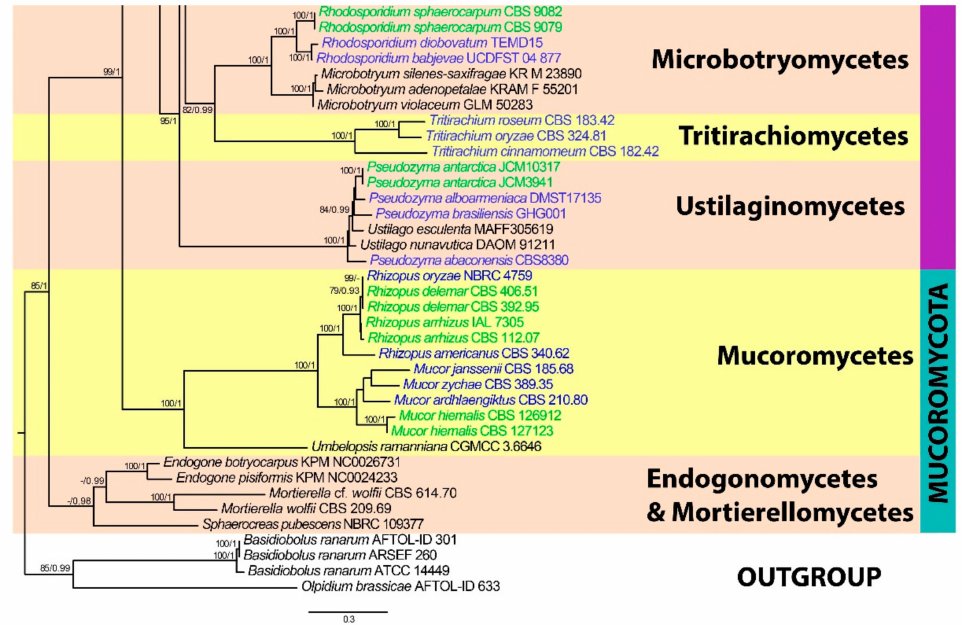
Figure 1. Phylogenetic relationships of plastic-degrading fungi. Phylogram generated from a max- imum likelihood analysis of ITS, LSU, SSU, TEF, RPB1 and RPB2 fungal sequence data. MLBP values ≥ 70% and BYPP ≥ 0.90 values are given as the first and the second set of numbers near the nodes. Strain/culture numbers are given after the taxon names. The tree is rooted with Basidiobolus ranarum AFTOL-ID 301, Basidiobolus ranarum ARSEF 260, Basidiobolus ranarum ATCC 14449, and Olpidium brassicae AFTOL-ID 633. Strains in Red: Strains directly reported as plastic degraders. Green: Other strain of the same species reported as plastic degraders. Blue: Other species in the same genus reported as plastic